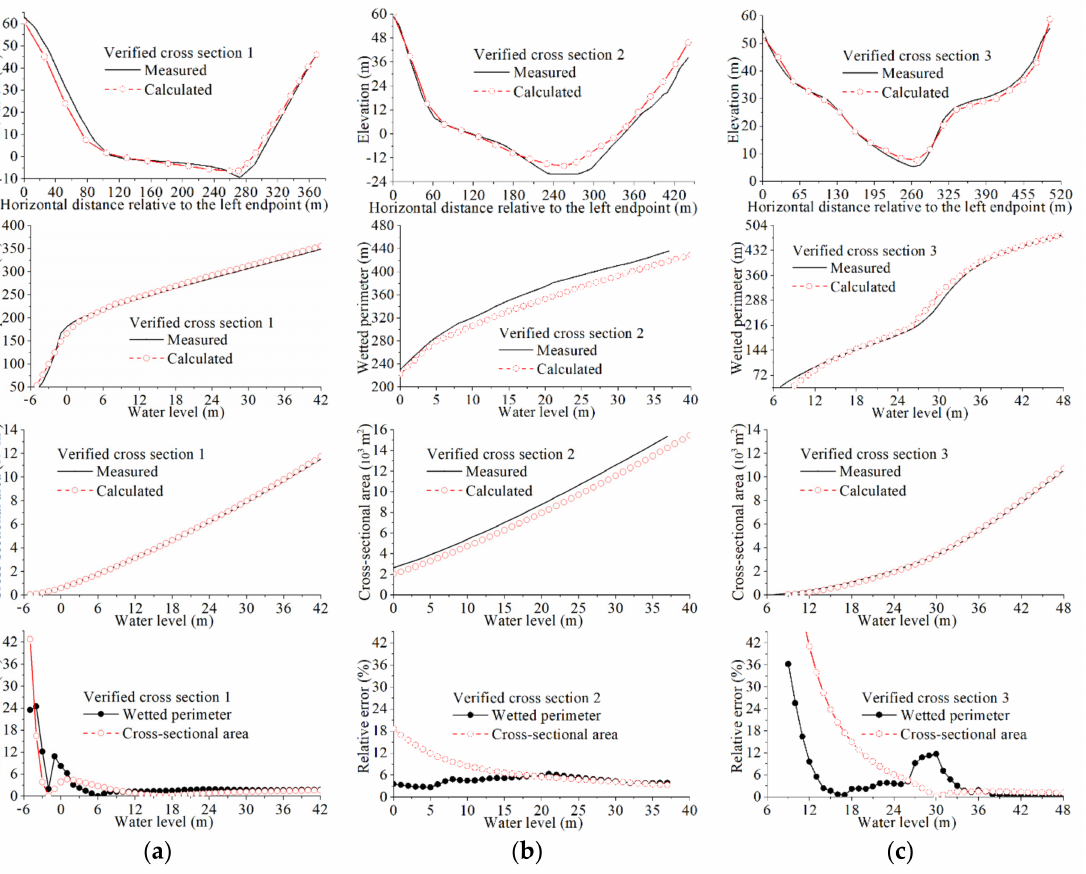
Figure 8. Comparisons between the measured and calculated results related to cross-sectional shape, wetted perimeter and cross-sectional area (( a ) corresponding to the verified cross section 1; ( b ) corresponding to the verified cross section 2; ( c ) corresponding to the verified cross section